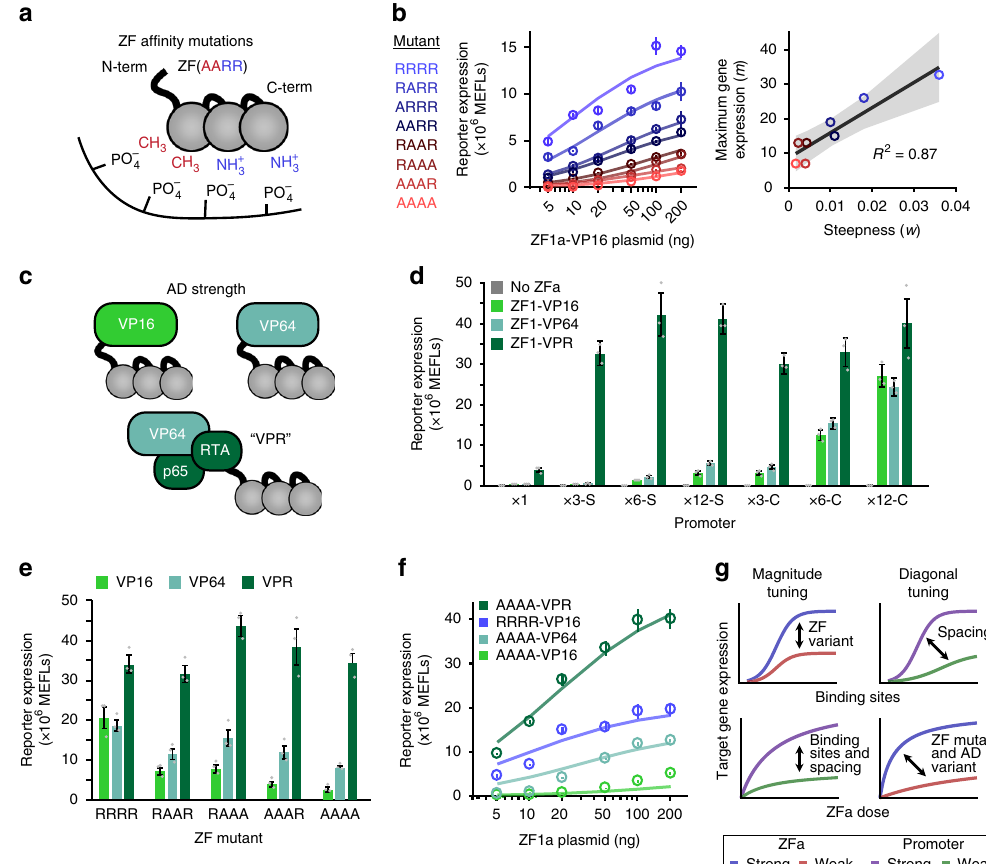
Fig. 4 Tuning transcription through ZF mutants and AD variants. a The cartoon illustrates arginine-to-alanine (R-to-A) mutations in the ZF domain, which decrease the DNA-binding af fi nity. b Left: ZF mutations modulate the steepness and the maximum of the ZFa dose response pro fi le. Circles represent experimental data and solid lines represent fi tted response function models. Right: correlation between m and w parameters across mutants. The regression line is m = 7.3 × 10 2 w + 8.6, and the shaded region is the 95% con fi dence interval (one-tailed permutation test p < 0.001). c The cartoon depicts evaluated ADs. d Effects of AD on inducible reporter expression with different promoters. Gene expression varied with the choice of promoter (two-factor ANOVA p < 0.001) and choice of AD ( p < 0.001), and an interaction was observed between these two variables ( p < 0.001). e Combined effects of AD variants and ZF mutations were identi fi ed. Gene expression was affected by both the ZF mutations (two-factor ANOVA p < 0.001) and the AD ( p < 0.001), with an interaction seen between these two variables ( p < 0.001). Each mutant ZFa induced more reporter expression with VP64 than with VP16 (one- tailed Welch ’ s t -test, all p < 0.05) and with VPR than VP64 (one-tailed Welch ’ s t -test, all p < 0.01). All VPR-ZFa induced similar expression regardless of the use of a WT or mutant ZF (Tukey ’ s HSD test with α = 0.05). f The choice of AD affects the steepness and the maximum of the dose response.